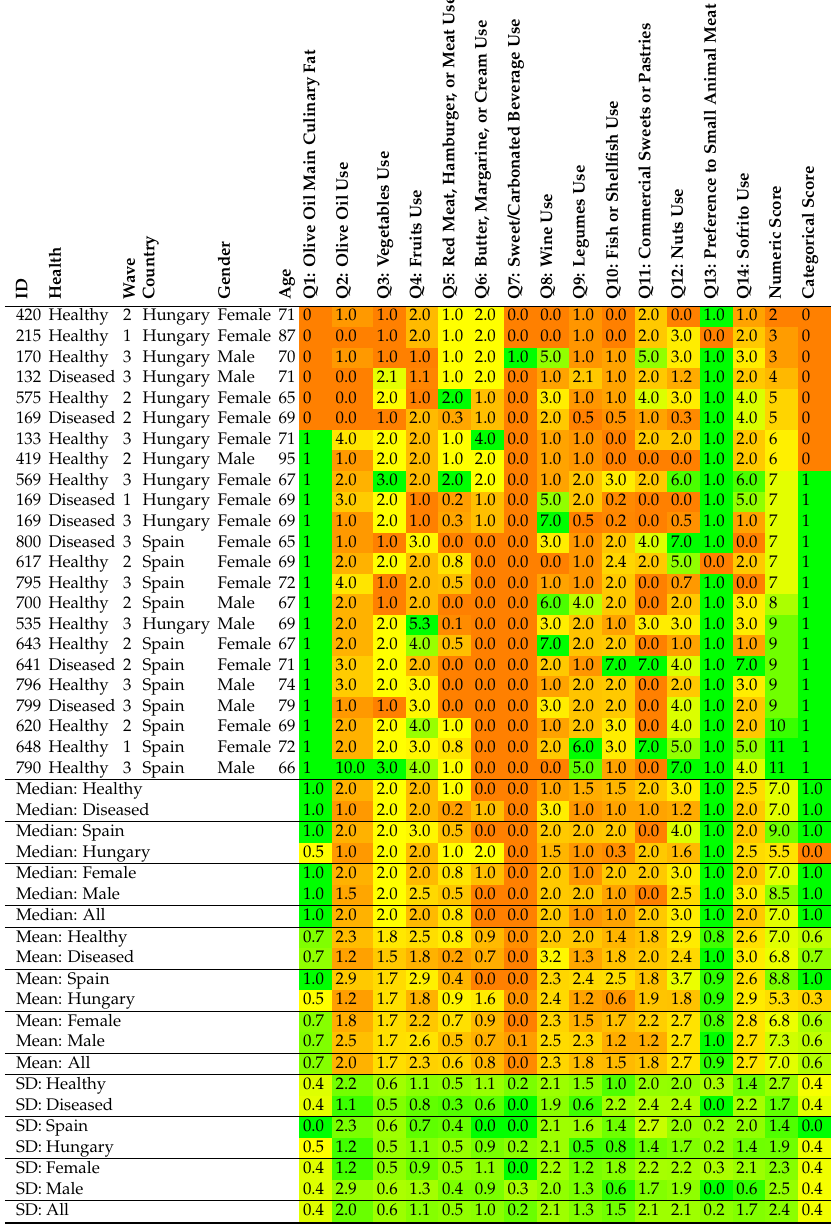
Table A6. Characteristics of PRO Mediterranean Nutrition (PREDIMED).